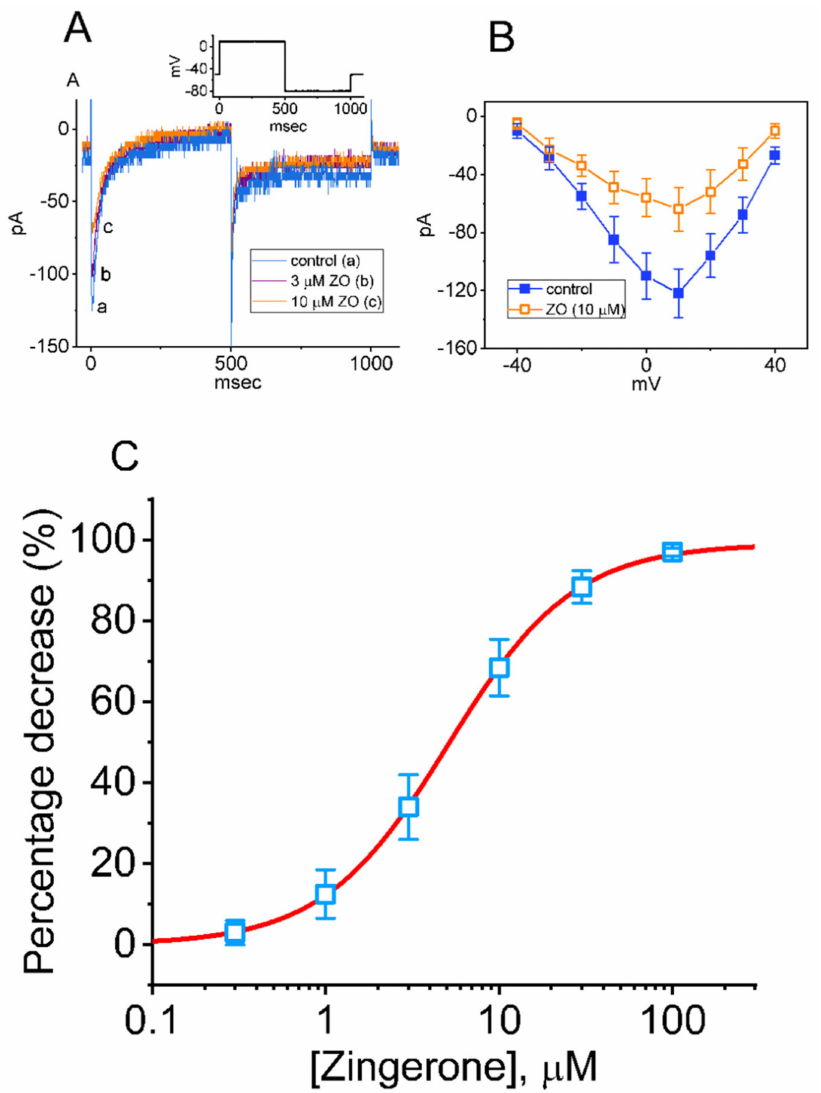
Figure 3. Inhibitory effect of ZO on the L-type Ca 2+ current ( I Ca,L ) identified in GH 3 cells. In these experiments, the cells were kept immersed in a normal Tyrode’s solution containing 1.8 mM CaCl 2 . The recording electrode was filled with Cs + -containing solution. ( A ) Representative current traces obtained under (a) the control situation (i.e., ZO was not present), and in the presence of 3 µ M ZO (b) or 10 µ M ZO (c). The inset shows the applied voltage-clamp protocol. ( B ) Mean current vs. voltage ( I–V ) relationships of peak I Ca,L in the absence ( (cid:4) ) and presence ( (cid:3) ) of 10 µ M ZO (mean ± SEM; n = 7 for each point). The current amplitude was measured at the start of each membrane depolarization to voltages ranging between − 40 and +40 mV from a holding potential of − 50 mV. ( C ) Concentration- dependent effect of ZO on the amplitude ( (cid:3) ) of I Ca,L evoked by membrane depolarization to +10 mV from a holding potential of − 50 mV (mean ± SEM; n = 8 for each point). The current amplitude was measured at the start of the depolarizing pulse during exposure to various concentrations of ZO. The continuous smooth line indicates the goodness-of-fit to the modified Hill equation, as stated in the Section